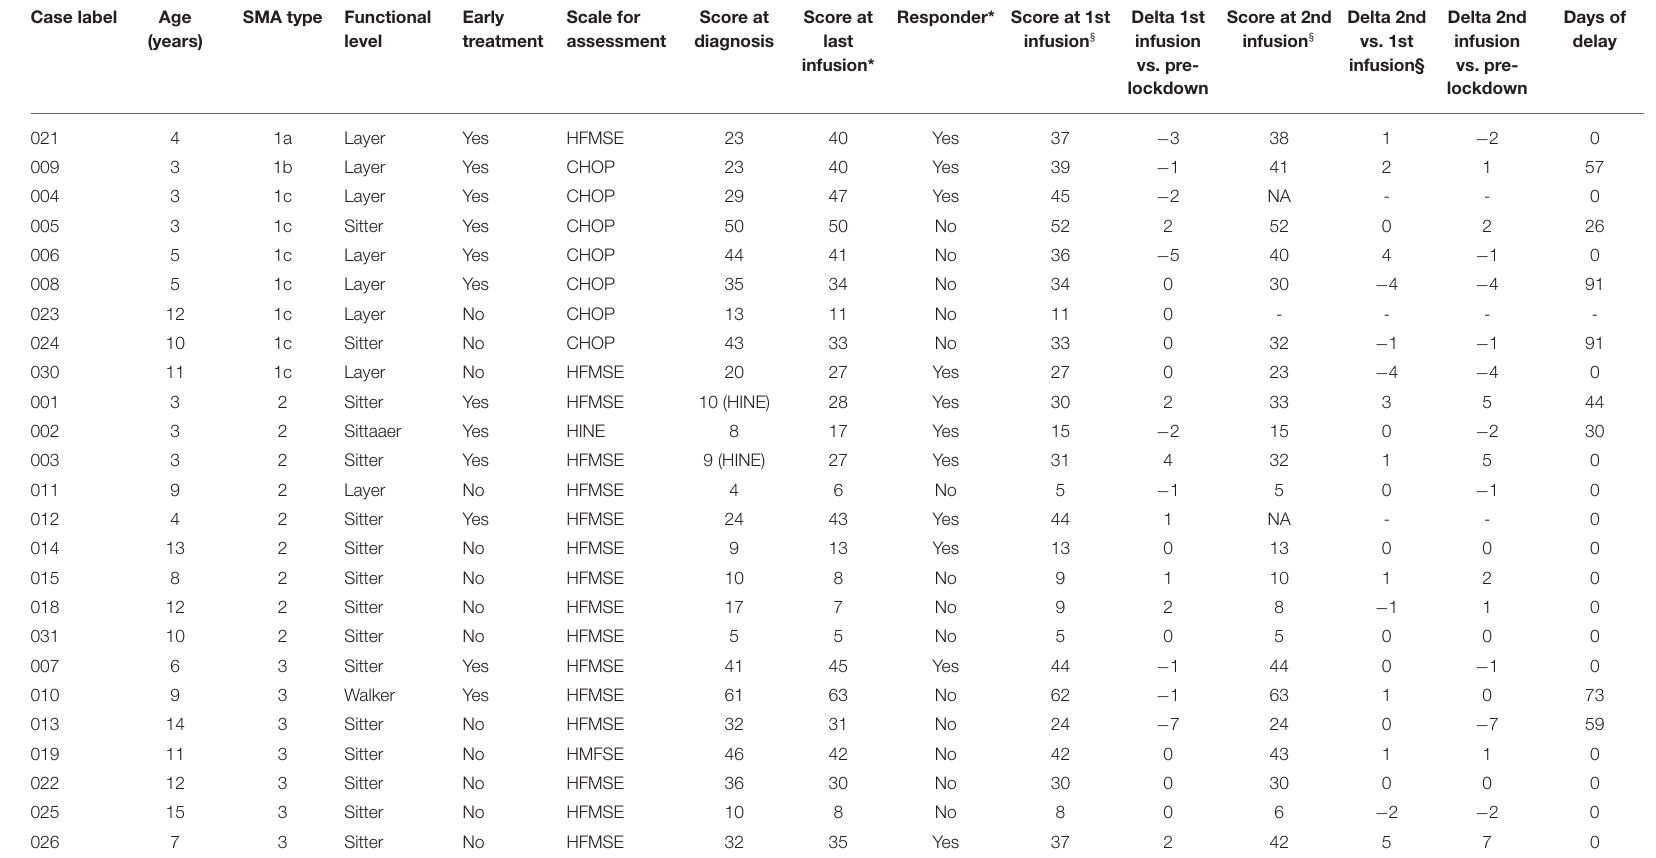
TABLE 2 | Patient data overview. Case